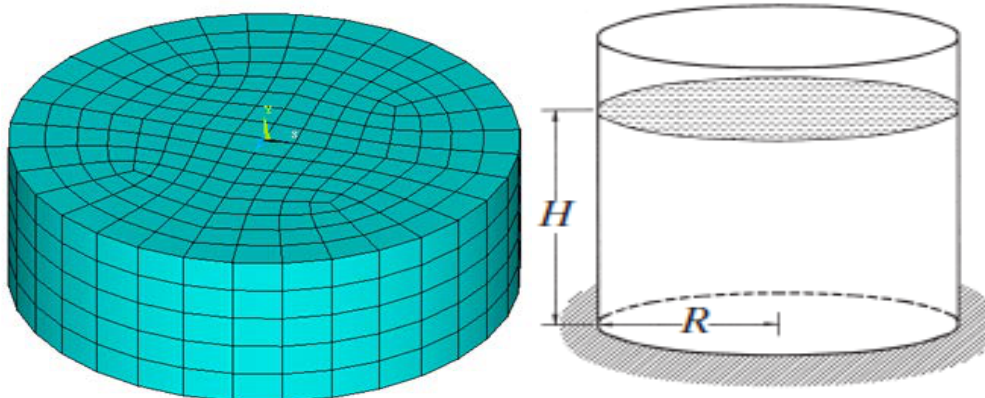
Fig. 2. FE modeling of